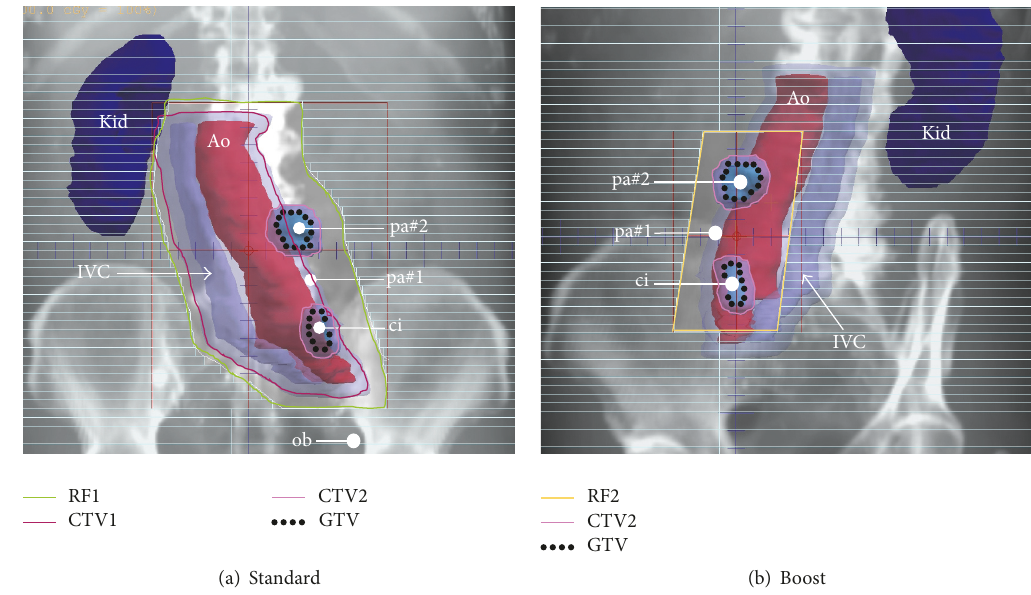
Figure 2: Irradiation conditions for the lymph nodes . (a) Frontal view of CT image reconstruction; RF1 was set based on CTV1 and 2 as standard radiation. (b) Left anterior oblique view of CT image reconstruction; RF2 was set based on CTV2 as a radiation boost. CT: computed tomography, RF: radiation field, GTV: gross tumor volume, CTV: clinical target volume, Ao: aorta, IVC: inferior vena cava, Kid: right kidney, ob: obturator lymph node, ci: left common iliac lymph node, and pa: para-aortic lymph